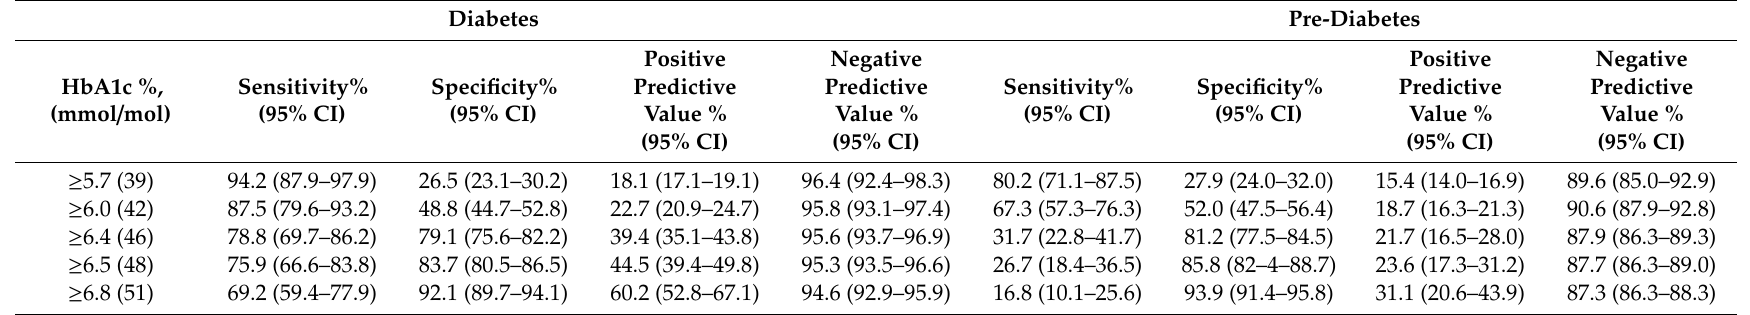
Table 2. Diagnostic properties of di ff erent HbA1c cut-o ff levels for detecting diabetes and pre-diabetes, applying the WHO criteria as the gold standard. Diabetes